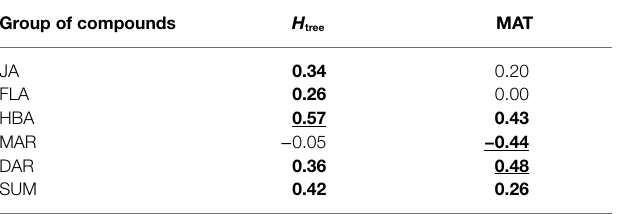
TABLE 3 | Linear correlations between secondary metabolite content in fine roots, sample tree height and mean annual temperature. Group of compounds H tree MAT JA 0.34